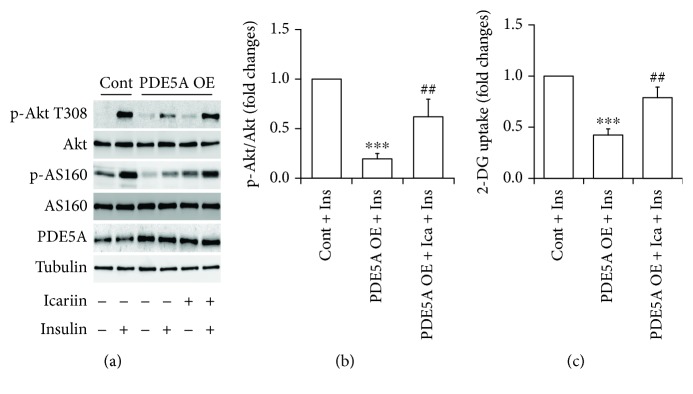
Effects of PDE5 inhibitor icariin (Ica) on insulin signaling in PDE5A-overexpressed C2C12 myotubes. (a) Representative western blots showing insulin- (INS-) stimulated phosphorylation of Akt T308 and AS160 in the cells treated with or without icariin; (b) quantification of the ration of phosphorylated Akt T308 to Akt protein in (a); (c) insulin-stimulated 2-DG uptake in the cells treated with or without icariin. N = 4. ∗∗∗P < 0.001 vs. the insulin-stimulated control group; ##P < 0.01 vs. the insulin-stimulated PDE5A-overexpression (OE) group.